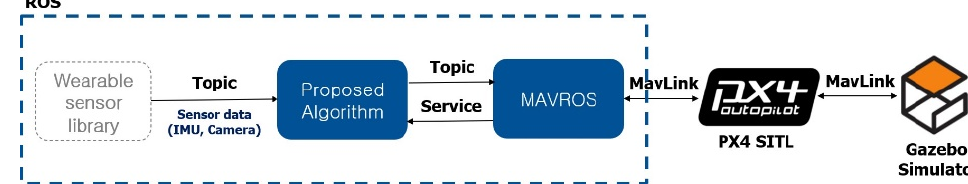
Figure 10. The simulation setup of proposed system.